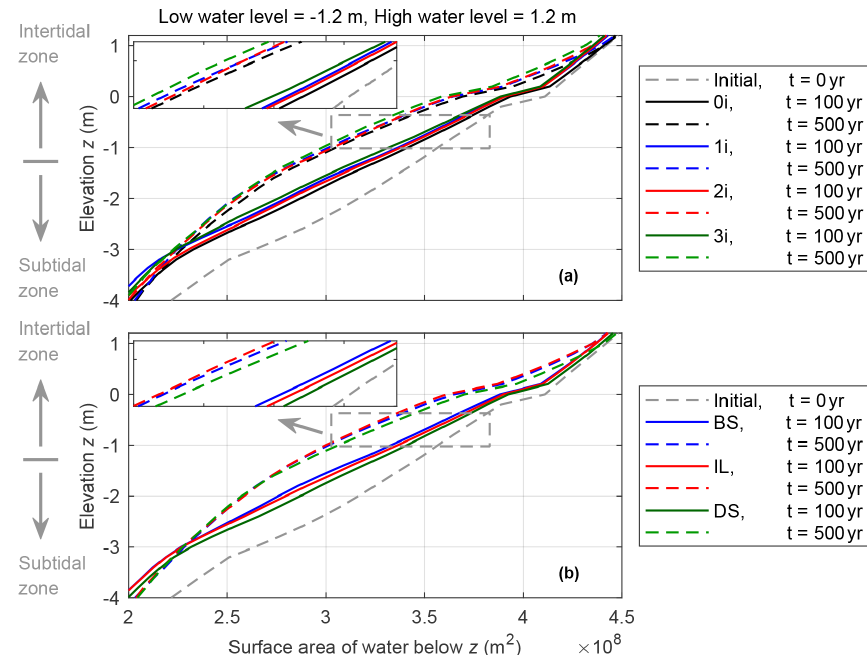
Figure 9. Hypsometry of the tidal basin for the simulations of different scenarios: (a) the scenarios of the different mouth island numbers; (b) the scenarios of different mouth island locations after 100 and 500 years, respectively. The tidal amplitude in all cases is 1.2m.